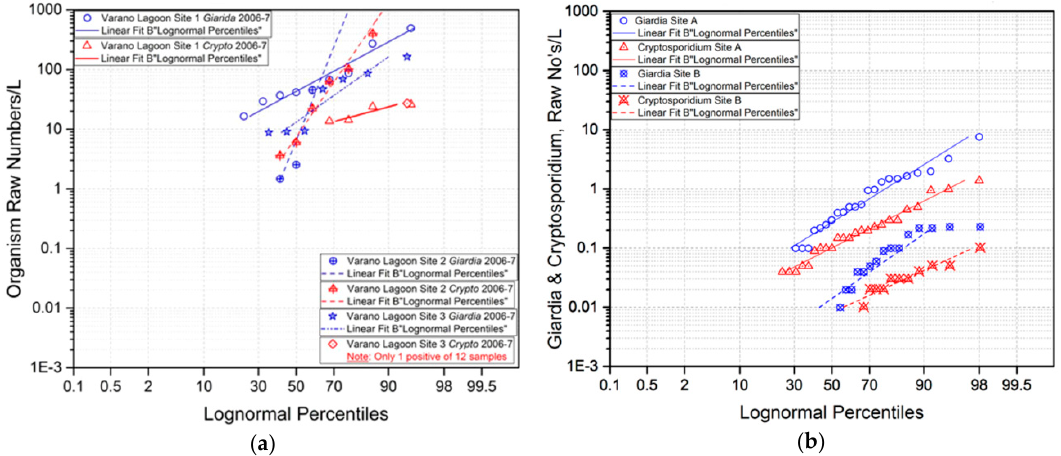
Figure 2. Cumulative frequency distributions ( a ) Cryptosporidium /L and Giardia /L at 4 sites in Italy, 2006-2007 [10]; ( b ) Cryptosporidium /L and Giardia /L at 2 sites in Luxembourg in 2006–2007 [11].